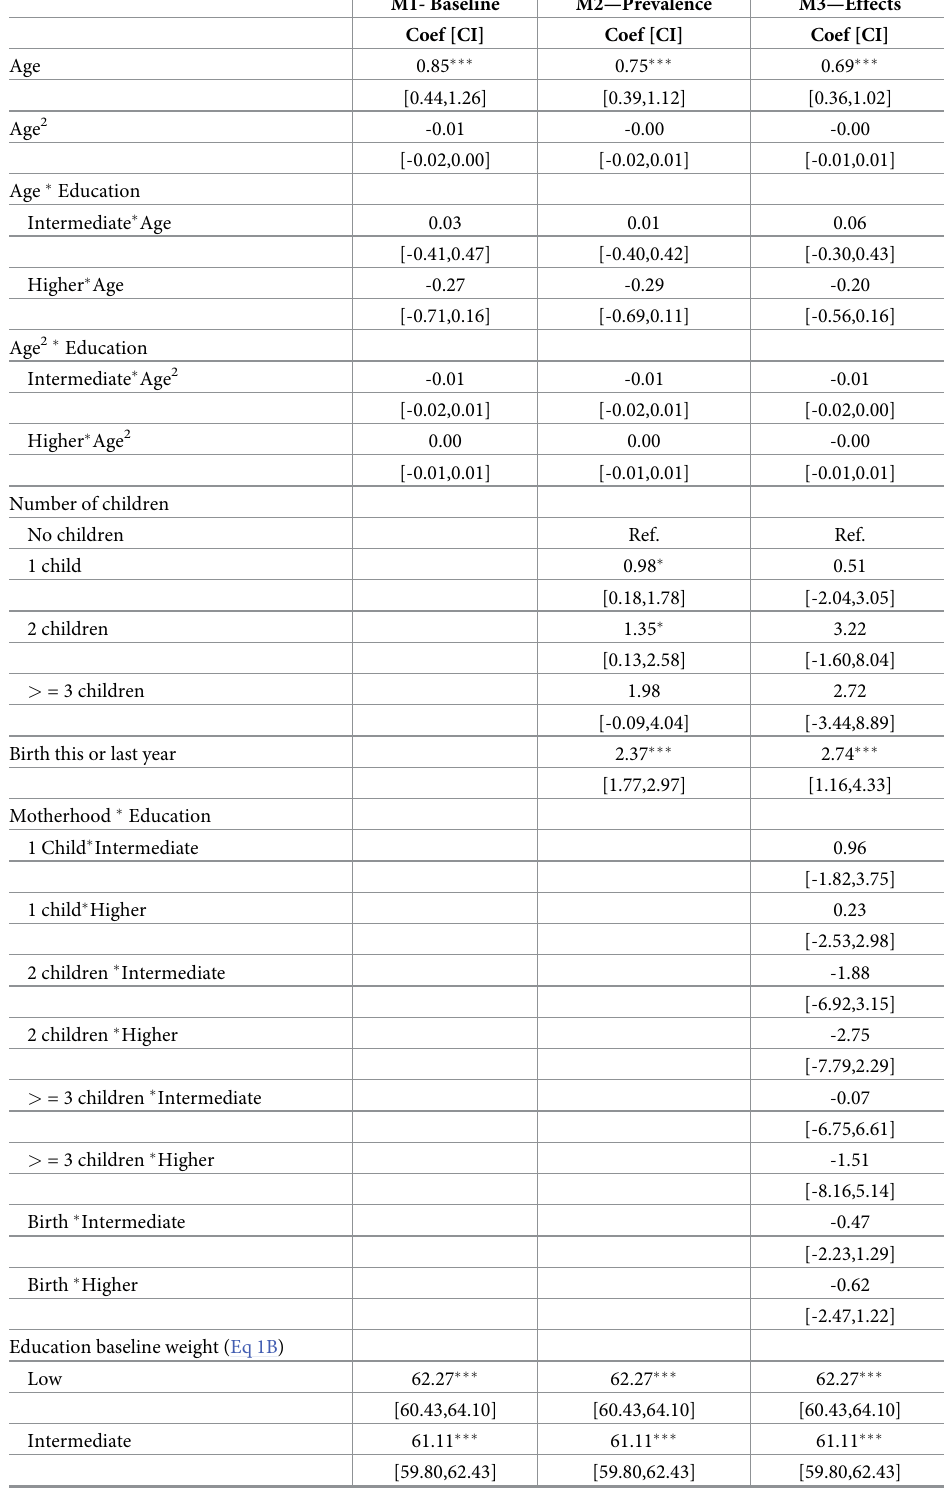
Table 2. Panel models for body